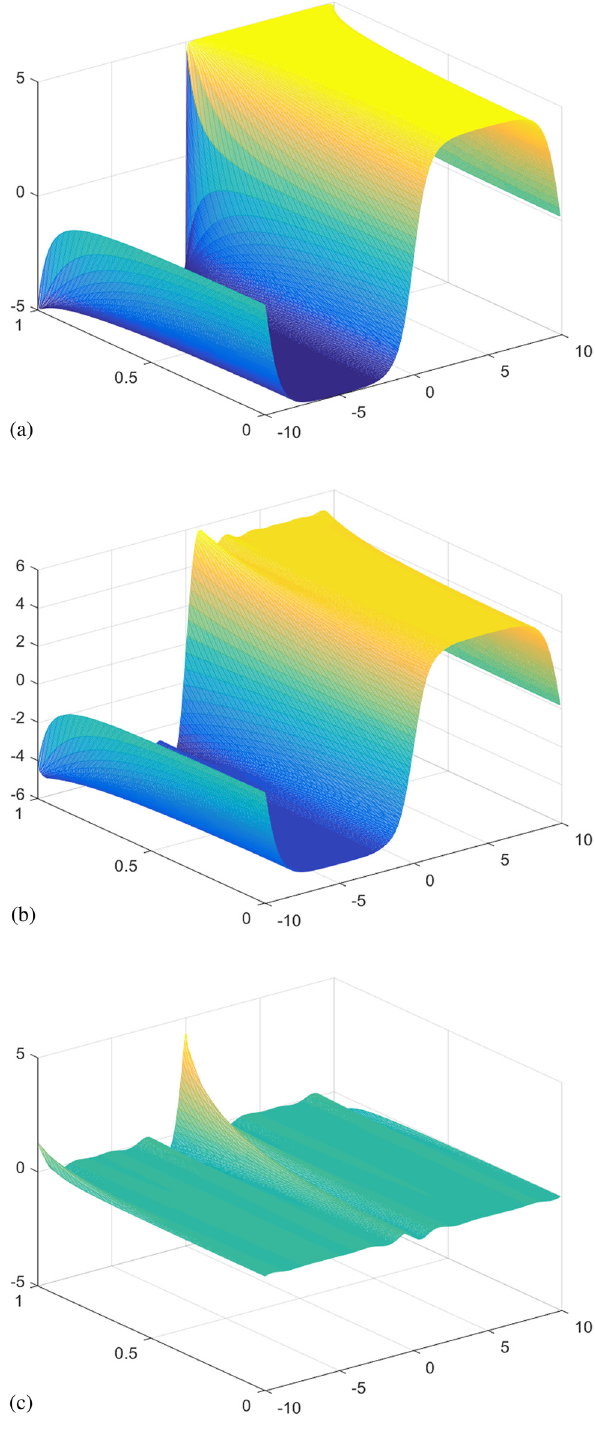
Figure 3: The exact solution, the regularization solution and error for